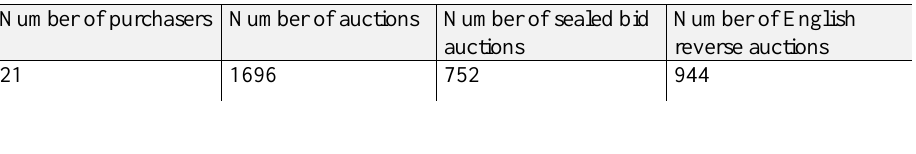
Table 1 – Sample description Number of purchasers Number of